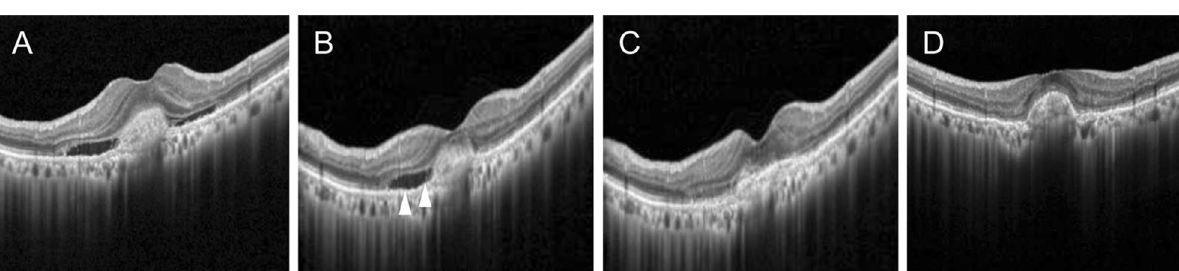
Figure 5. A representative case showing differences in the prediction of post-treatment retinal fluid status, according to the type of anti-vascular endothelial growth factor agent. ( A ) Subretinal fluid (SRF) is noted on the optical coherence tomography image obtained before treatment. Residual SRF is noted (arrowheads) on the artificial intelligence (AI)-synthetic image after ranibizumab treatment ( B ), whereas the complete resolution of retinal fluid is noted on the AI-synthetic image after aflibercept treatment ( C ). Complete resolution of retinal fluid is noted on a real image after aflibercept treatment ( D